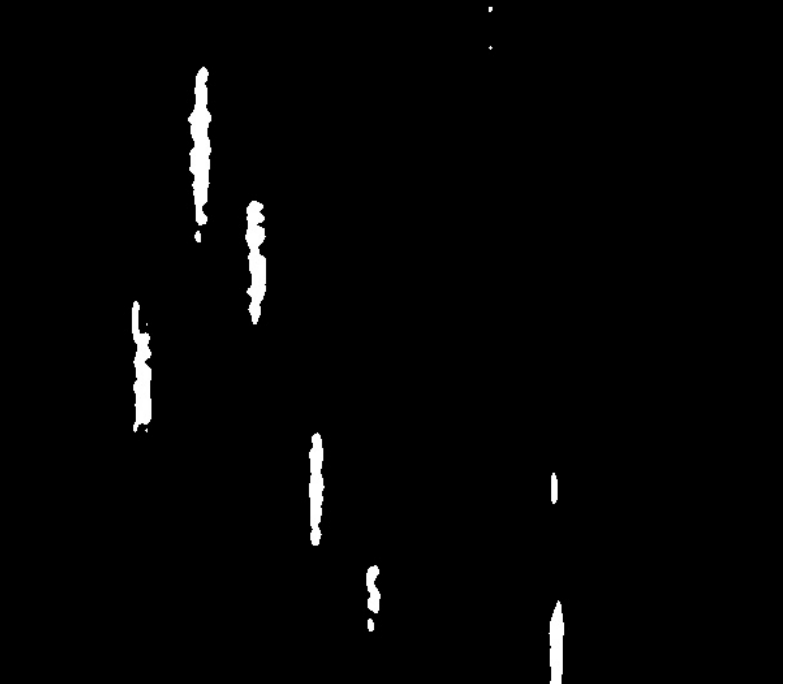
Figure 6. After obtaining the greyscale image of each channel, Otsu thresholding is applied, giving a binary image